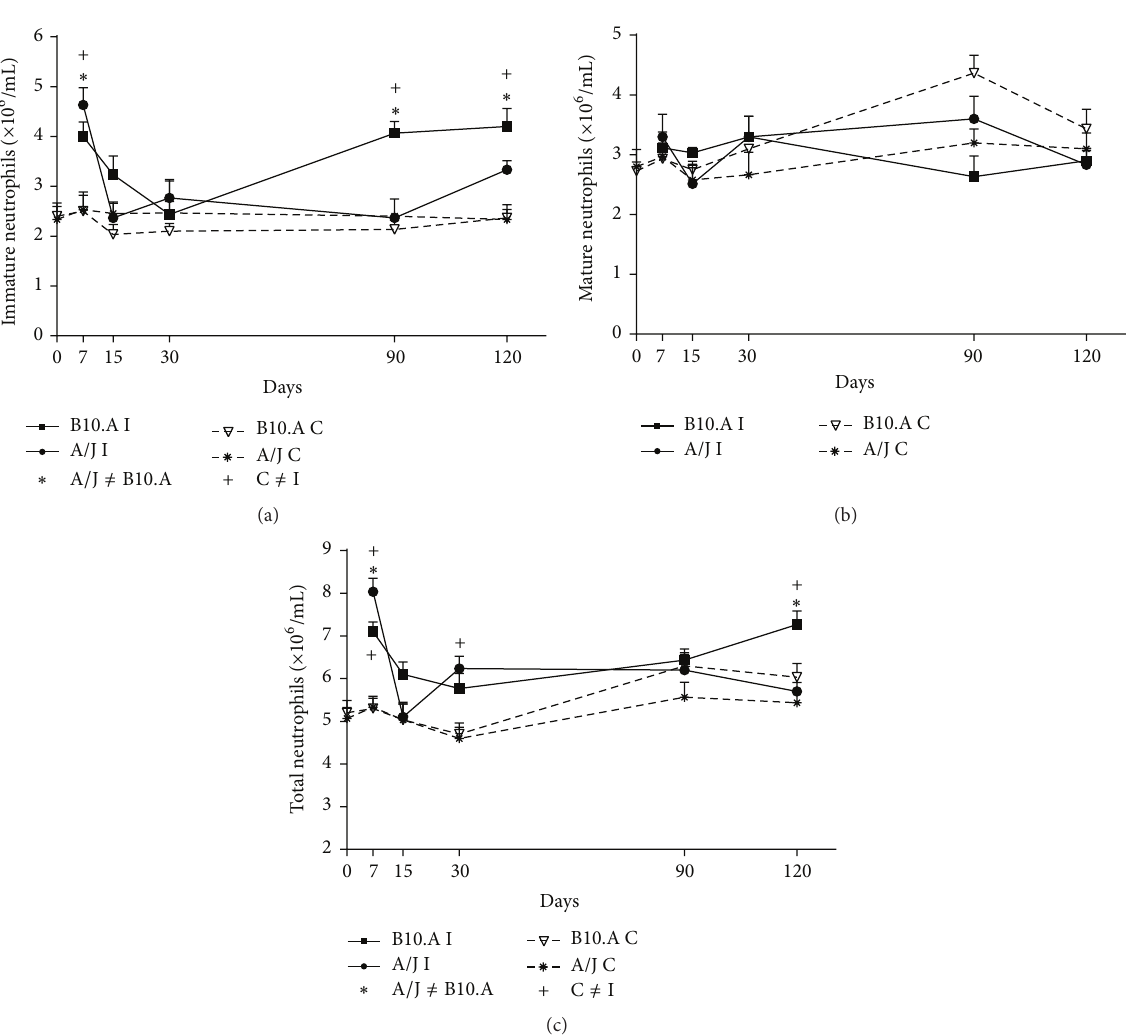
Figure 1: Kinetics of PMN population in bone marrow following intraperitoneal inoculation of Pb : (a) immature PMN population after intraperitoneal inoculation; (b) mature PMN population after intraperitoneal inoculation; (c) total PMN population after intraperitoneal route; A/J and B10.A: resistant and susceptible mice,